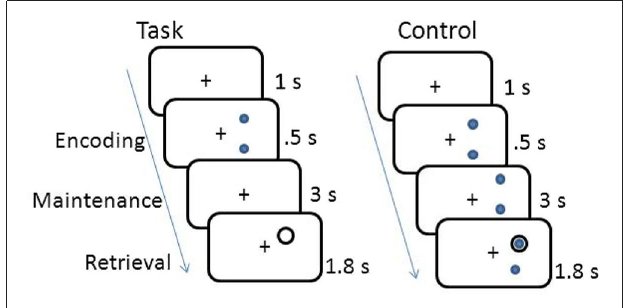
FIGURE 1 | Schematic of working memory and control tasks